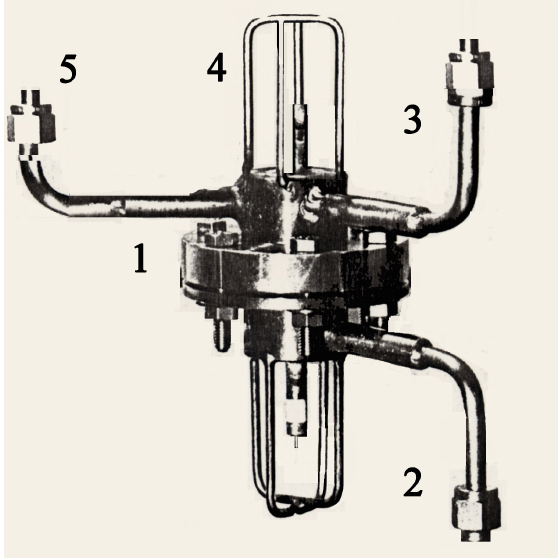
Figure 1. Device working with flat diffusion cathode (1) electrolyzer, (2) towards tank for hydrogen storage, (3) oxygen extraction, (4) water injection, (5) neutral gas